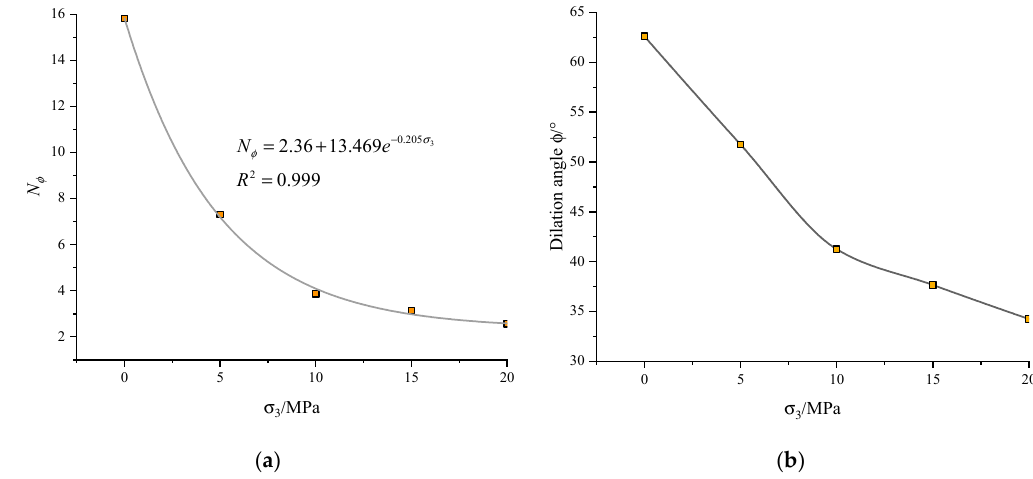
Figure 7. The evolution of ( a ) plastic strain increment N φ and ( b ) dilation angle φ with the confining pressure.